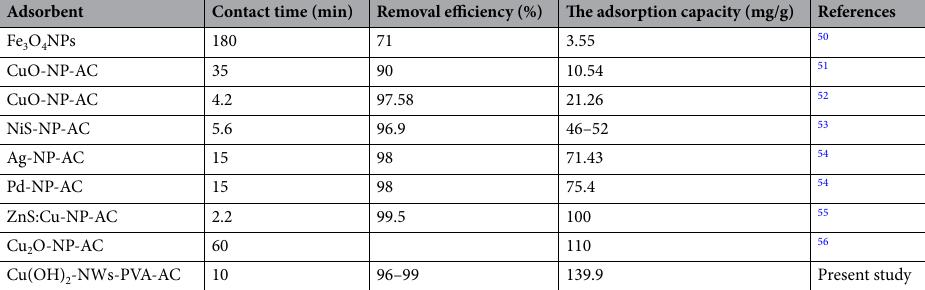
Table 6. Comparison of MB removal by different adsorbents with Cu(OH) 2 -NWs-PVA-AC.